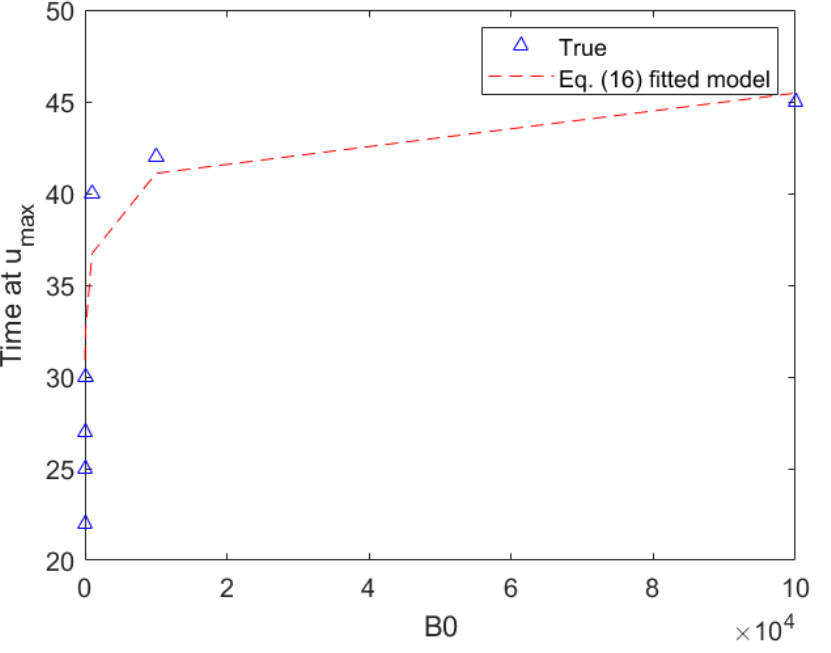
Figure 7. The t max time of Policy 1 against the changes in B 0 of Equation (15), against the fitted model Figure 7. The max t time of Policy 1 against the changes in 0 B of Equation (15), against the fitted of Equation (16). model of Equation (16). B is now plotted in t time against the parameters For Policy 2, the plot of the max 0 Figure 8. The plot again suggests a similar nonlinear logarithmic relationship to Equation u B for both control inputs t with respect to the changes in (16) for the function of 1 max 0 and